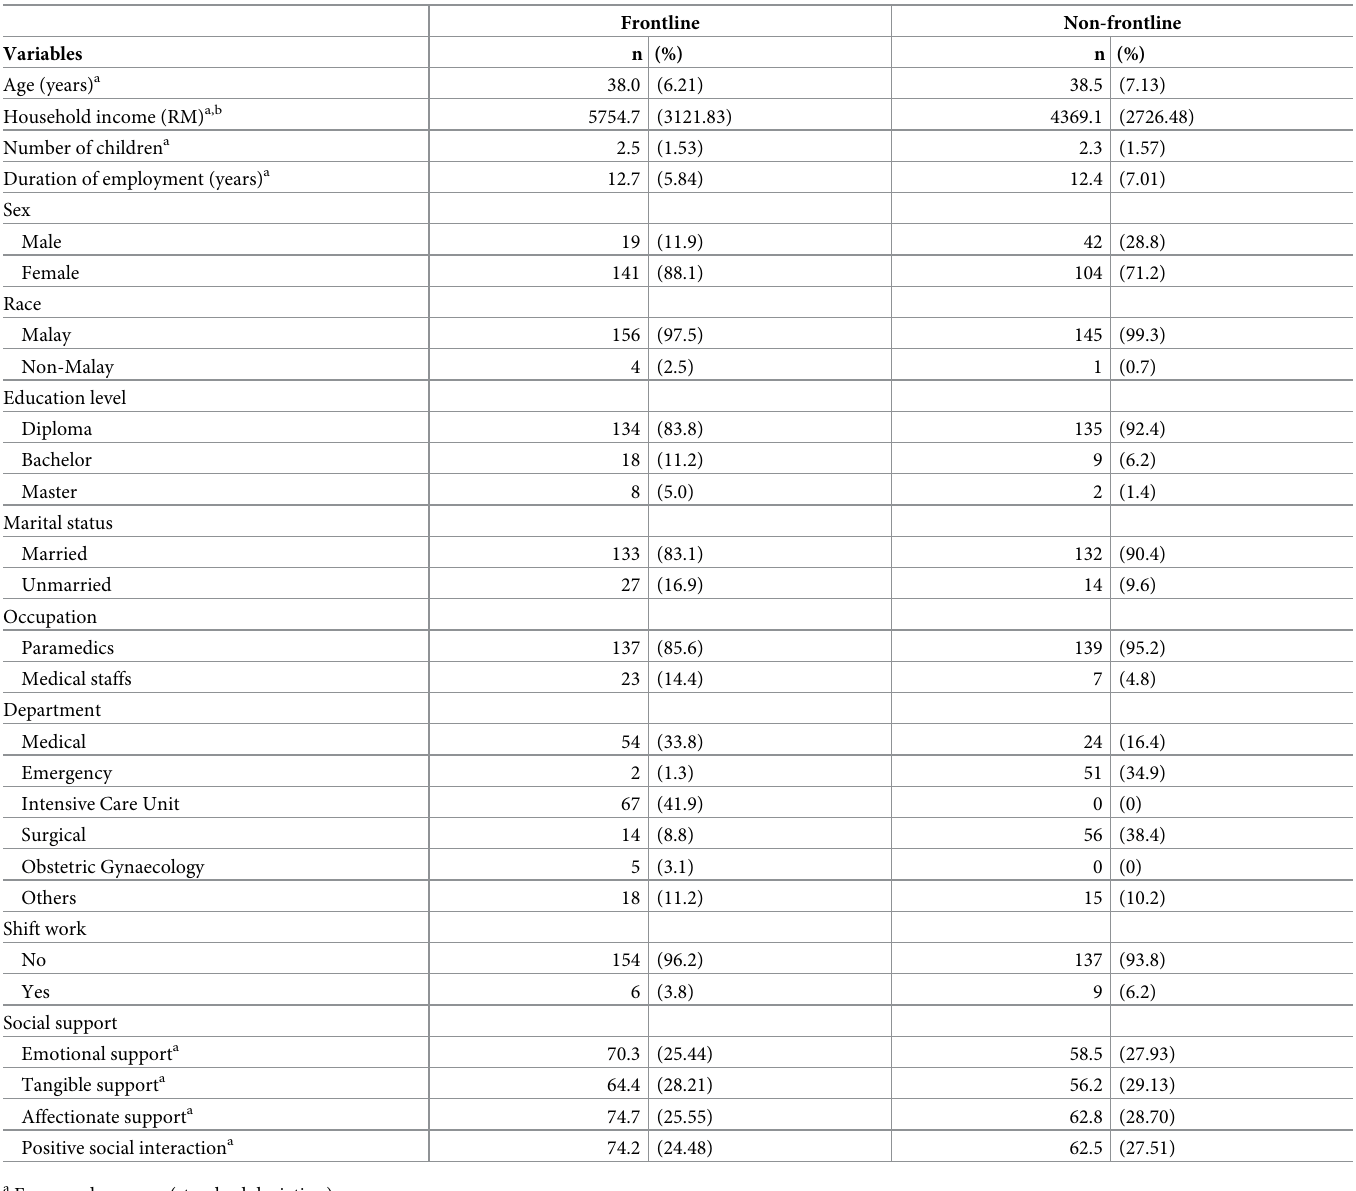
Table 1. Socio-economic characteristics of healthcare